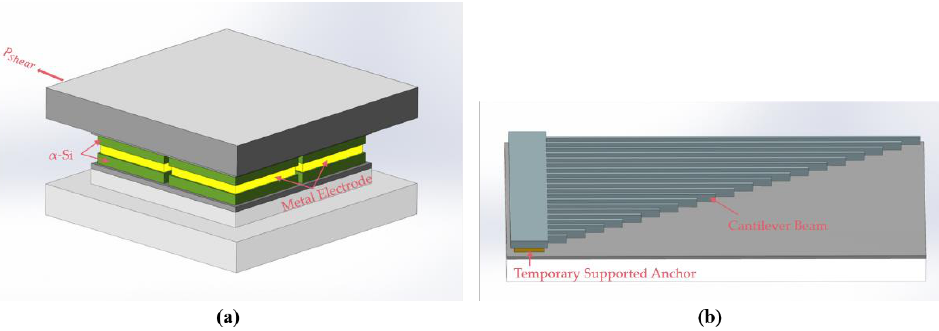
Figure 5. ( a ) Schematic of Au–Si eutectic bonding strength estimated by shear force test; ( b ) Proto- type of 20 different types of cantilever beam designed to estimate the magnitude of the temporary bonding strength caused by